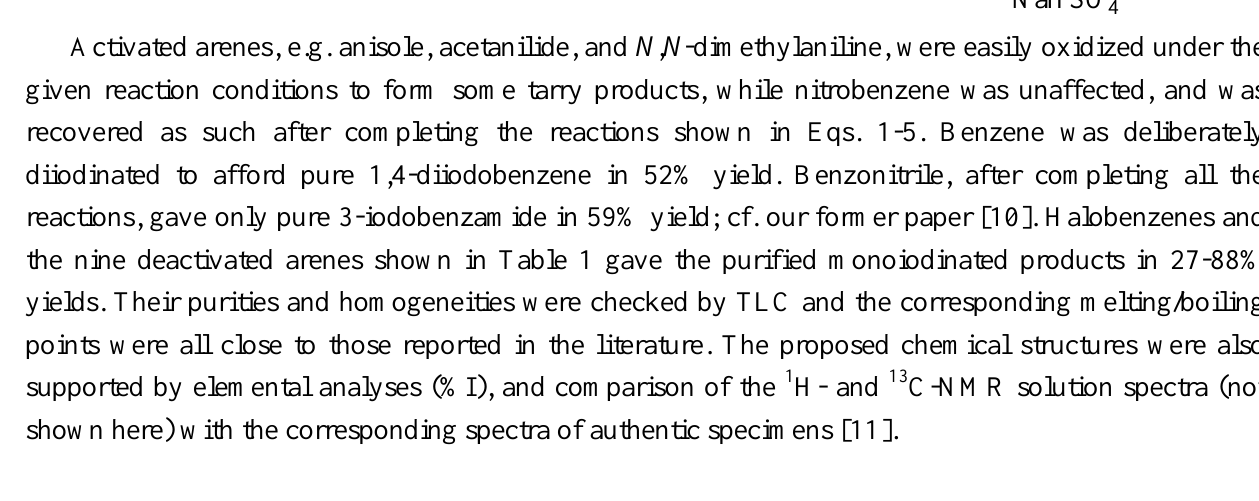
Table 1. Iodinated Pure Products Prepared and Volumes of Concd. H